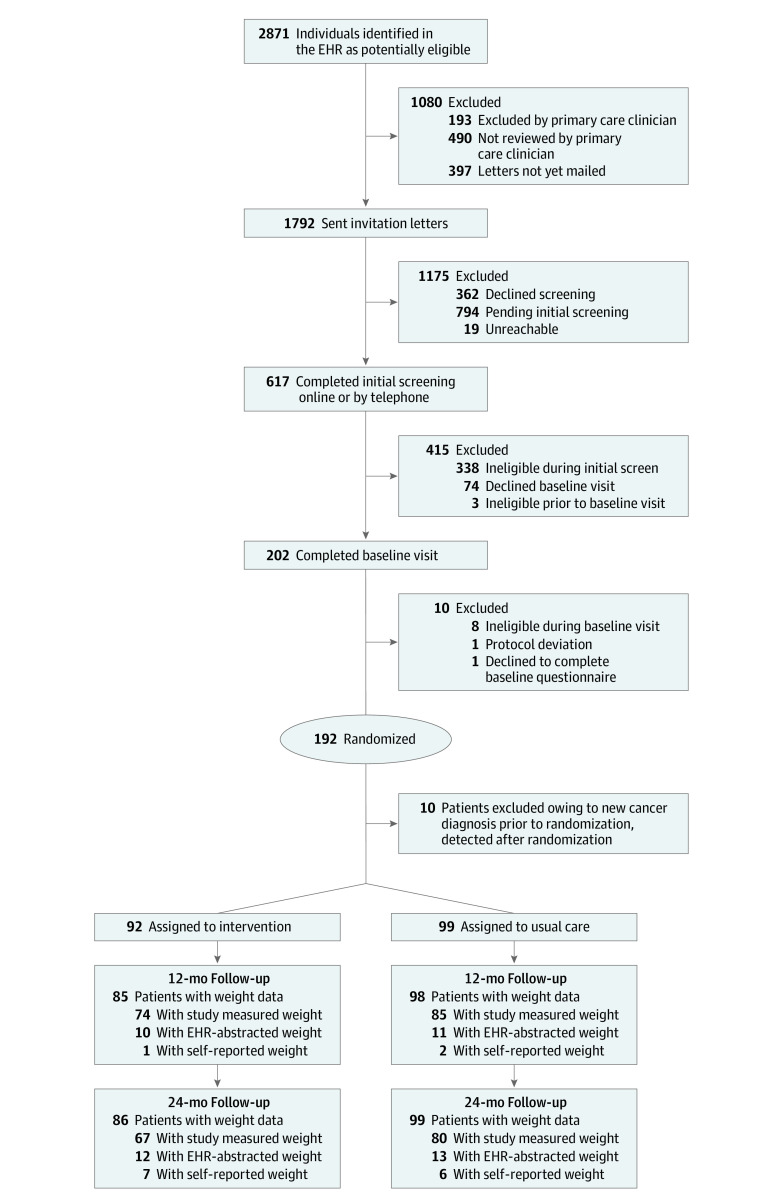
Participant Enrollment FlowchartEHR indicates electronic health record.